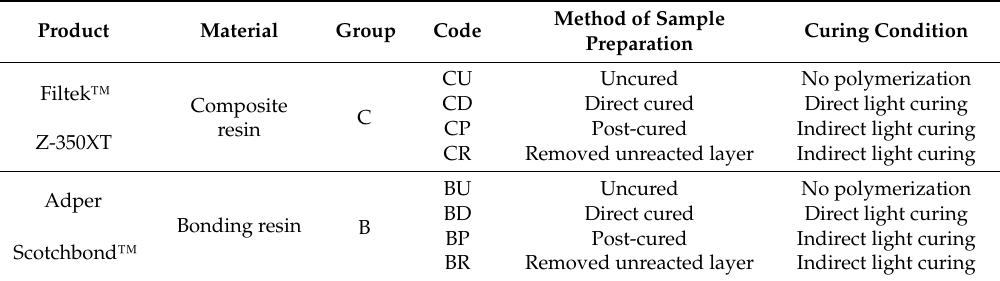
Table 2. Experimental conditions.